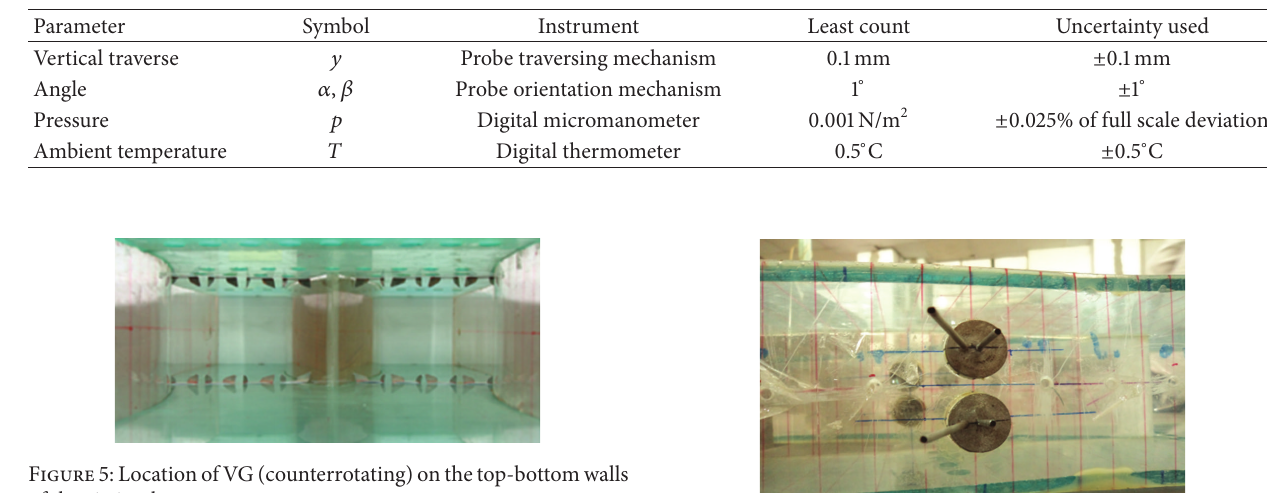
Table 1: Least count and uncertainty in the measured parameters.